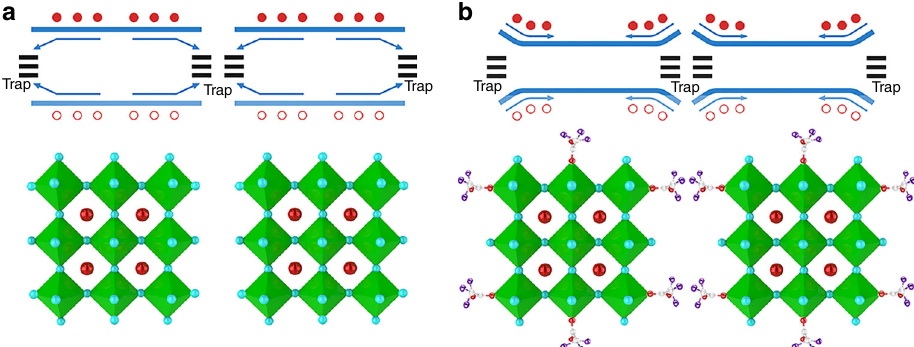
Fig. 5 Grain boundary passivation mechanism. Schematic diagram of grain boundary passivation mechanism for a CsBr- and b CsTFA-derived